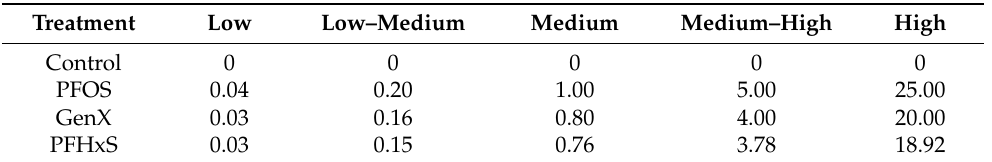
Table 1. Nominal concentrations ( µ g/L) of PFOS, GenX and PFHxS used in three separate Aus- trochiltonia subtenuis 7-day exposures using analytical-grade PFAS